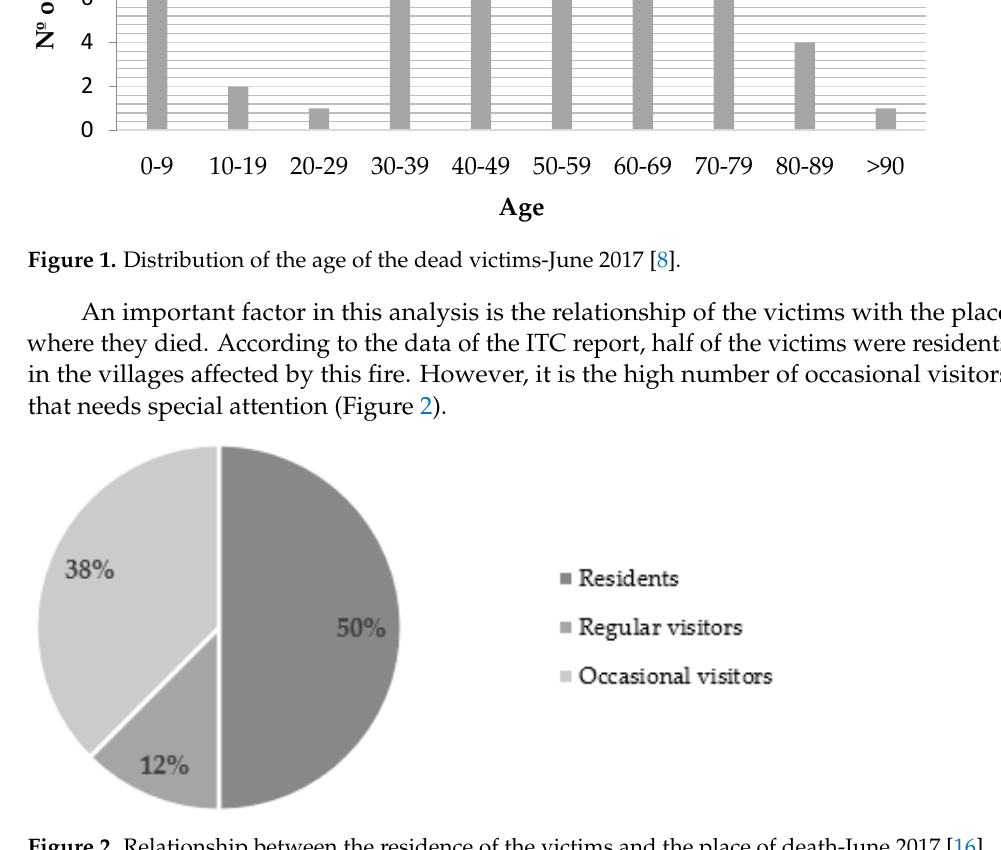
Figure 2. Relationship between the residence of the victims and the place of death-June 2017 [16].